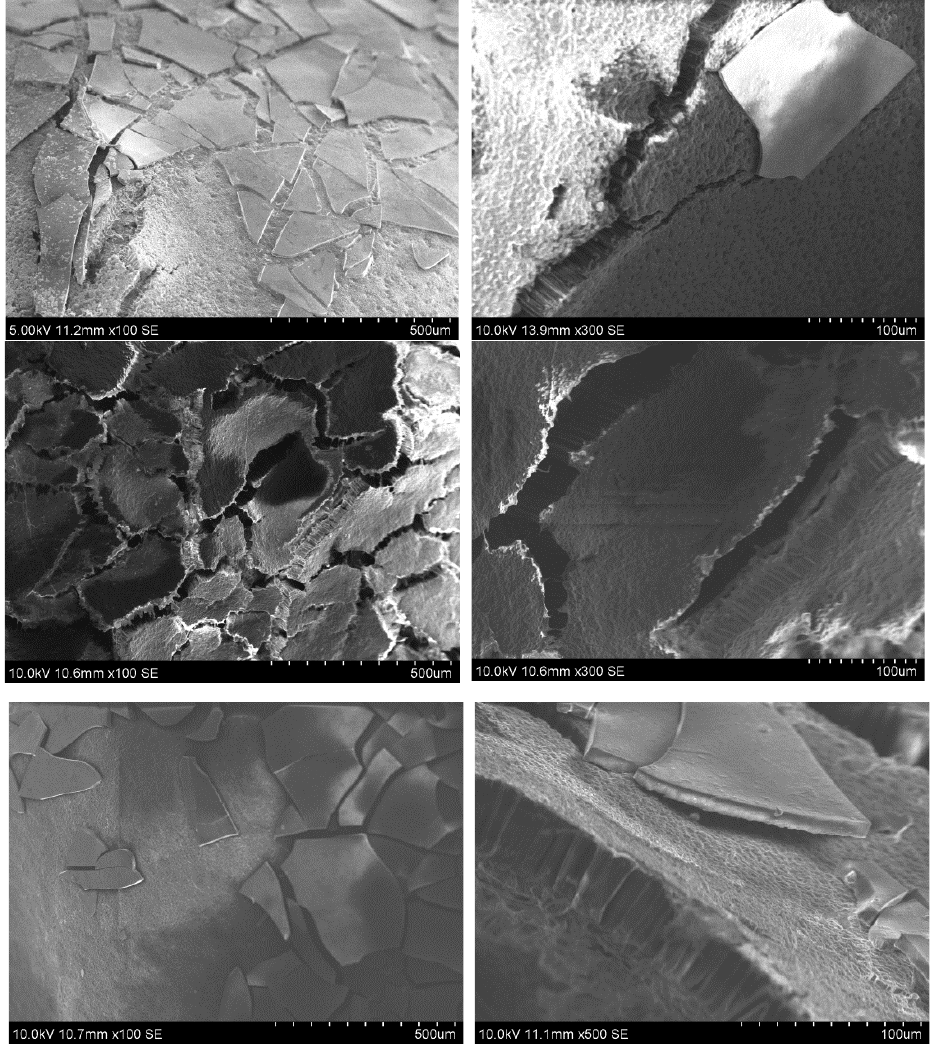
Figure 7. SEM micrographs of the pea seeds after germination test: first row —seed with pure SiO 2 coating; second row —seed with thinner SiO 2 -fertilizer coating; and third row —seed with thicker SiO 2 -fertilizer coating.